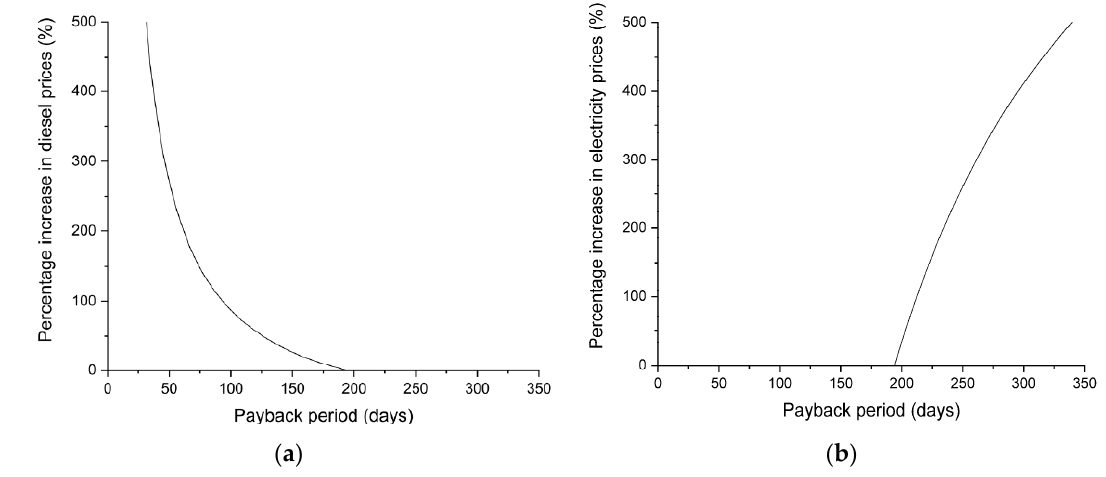
Figure 7. Sensitivity analysis showing the influence of ( a ) diesel price and ( b ) electricity price in the pneumatic dryer payback period.